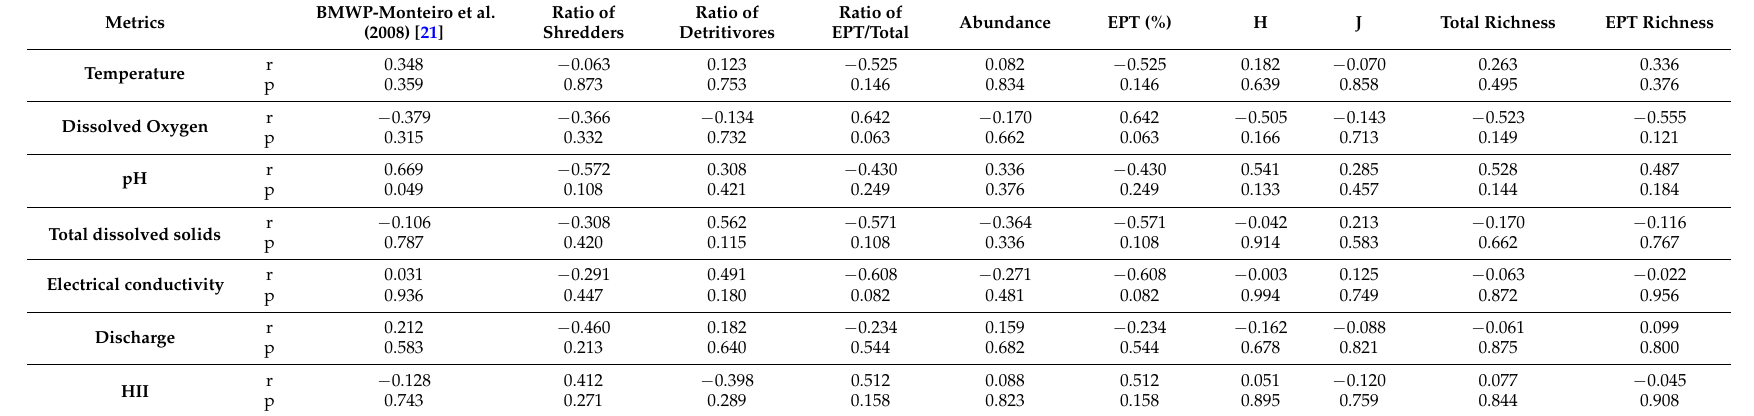
Table 7. Correlations between metrics based on macroinvertebrate fauna and abiotic data, including the Habitat Integrity Index for nine streams of Taquaruçu Grande river basin, State of Tocantins,